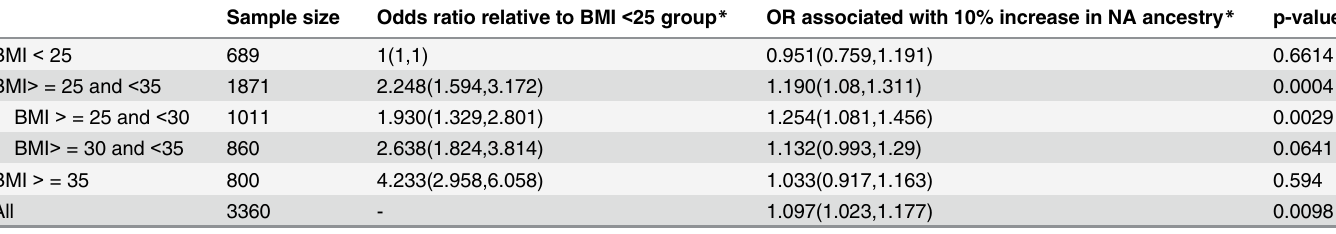
Table 5. Regressing Native American genetic ancestry with diabetes risk by BMI in women. Sample